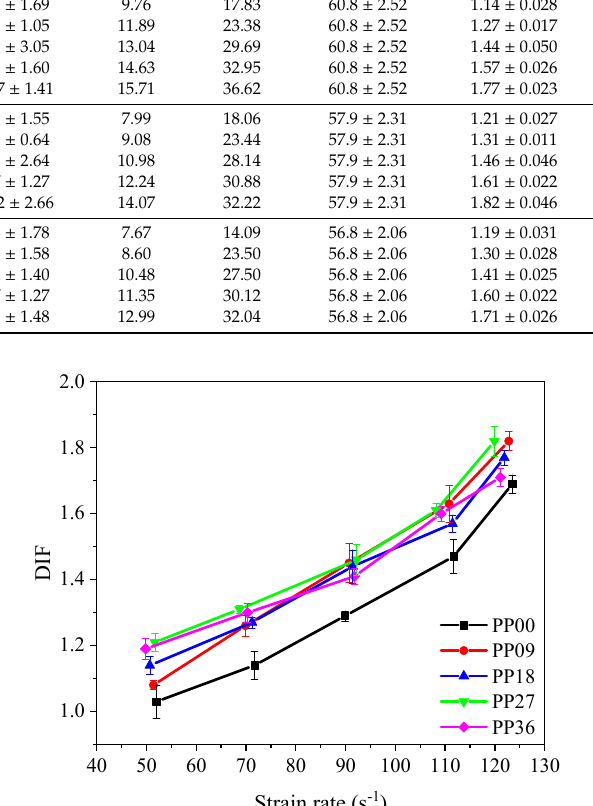
Figure 8. E ff ect of strain rate on Figure 8. Effect of strain rate on DIF.